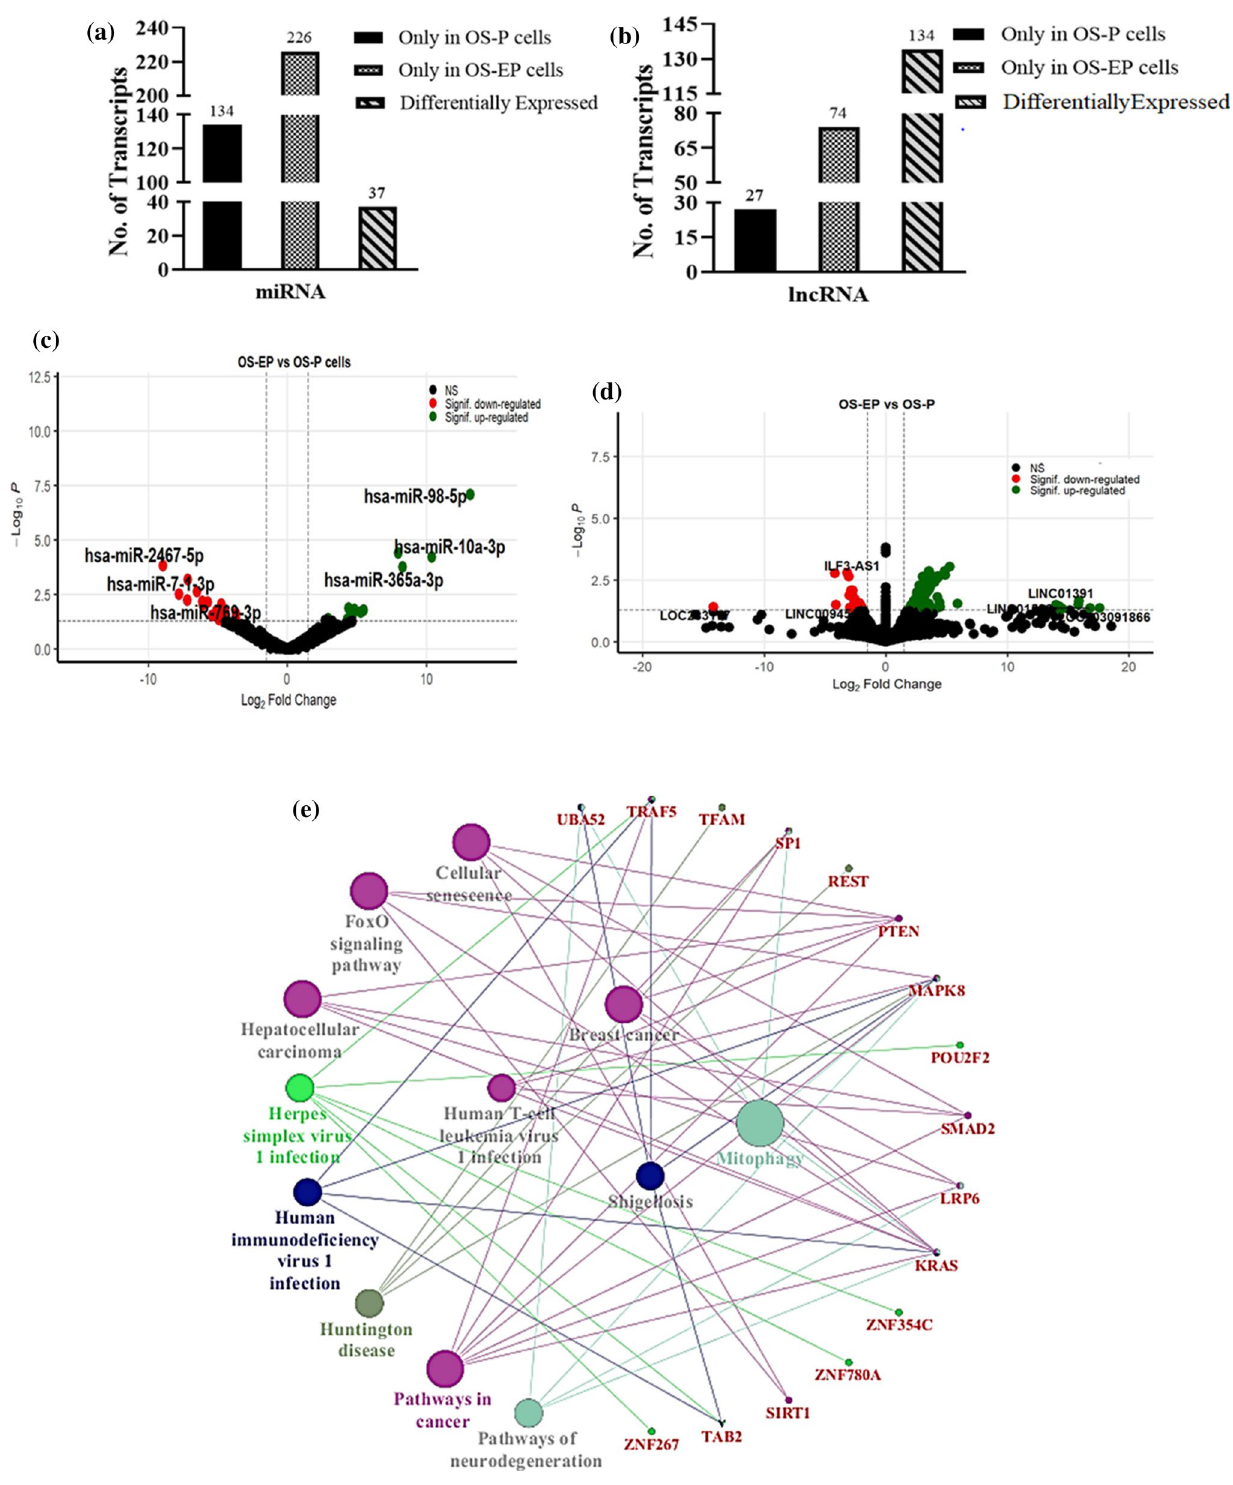
Fig. 3 Comparative transcriptomic analysis of cells under cisplatin shock (OS-P) with revived cells (OS-EP). The bar graph represents the a miRNA transcript and b lncRNA transcript distribution representing the treatment-specific, control-specific and differentially regulated transcripts. In each case, transcripts with a p-value ≤ 0.05 were considered. c , d Volcano plot representing the upregulated (green dots) and downregulated (red dots). c miRNA transcripts. d lncRNA transcripts are shown. The names of the top three up- and downregulated miRNA and lncRNA transcripts are men- tioned within the plot. Horizontal and vertical dashed lines indicate significance threshold corresponding to an adjusted p-value of ≤ 0.05 and log- 2fold change of ± 1.5 e Cytoscape network showing key genes (labeled in red color) and its pathways regulated by significantly dysregulated miRNAs in OS-EP vs. OS-P set. The key miRNA-regulated genes are densely connected with pathways such as the mTOR signaling pathway, MAPK signaling, autophagy, cellular senescence and apelin